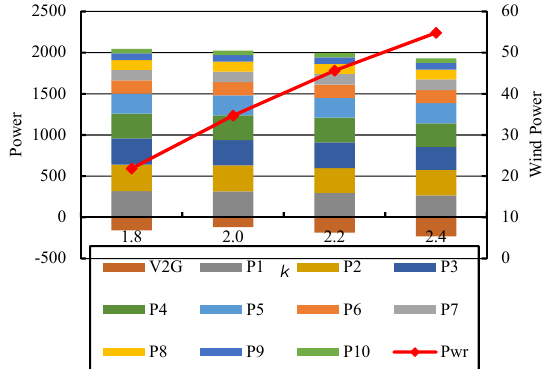
Figure 18. Output power at different shape factors.